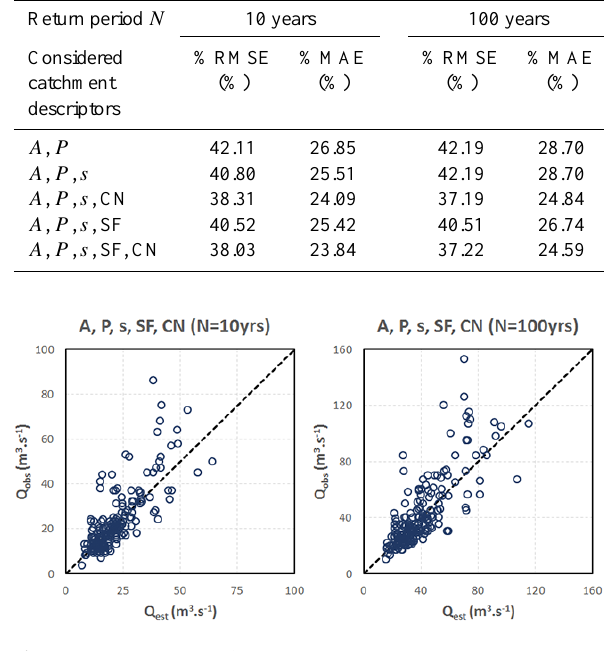
Figure 10. Scatterplot of observed versus estimated discharge val- ues for a combination of catchment area, maximum daily precipita- tion total, average catchment slope, shape factor and curve number for T = 10 years (left panel) and T = 100 years (right